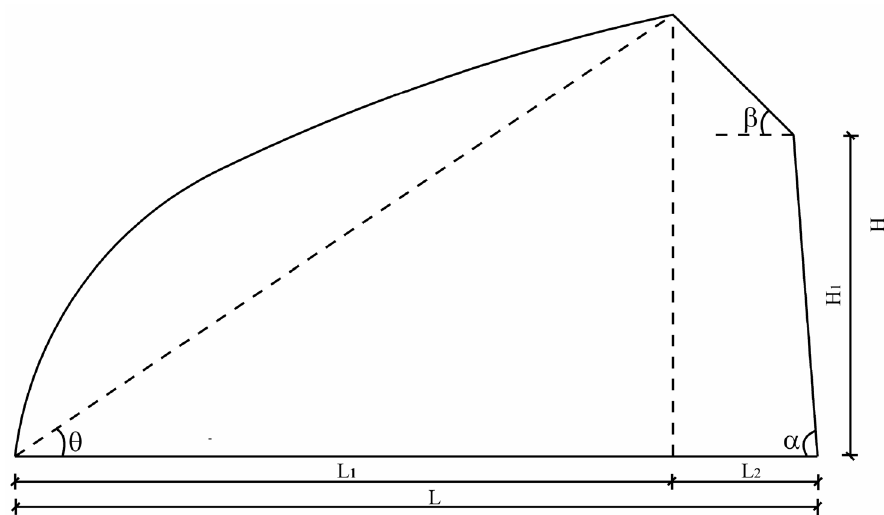
Figure 1. Section size of greenhouse.